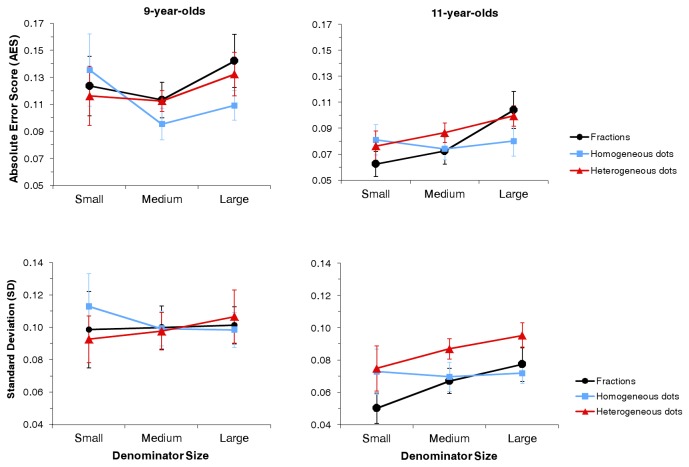
The mean absolute error score (top panel) and the mean standard deviation (bottom panel) according to the denominator size and the ratio format by age group.Error bars represent the 95% confidence intervals corrected according to the method suggested by Cousineau [44] for repeated measures.